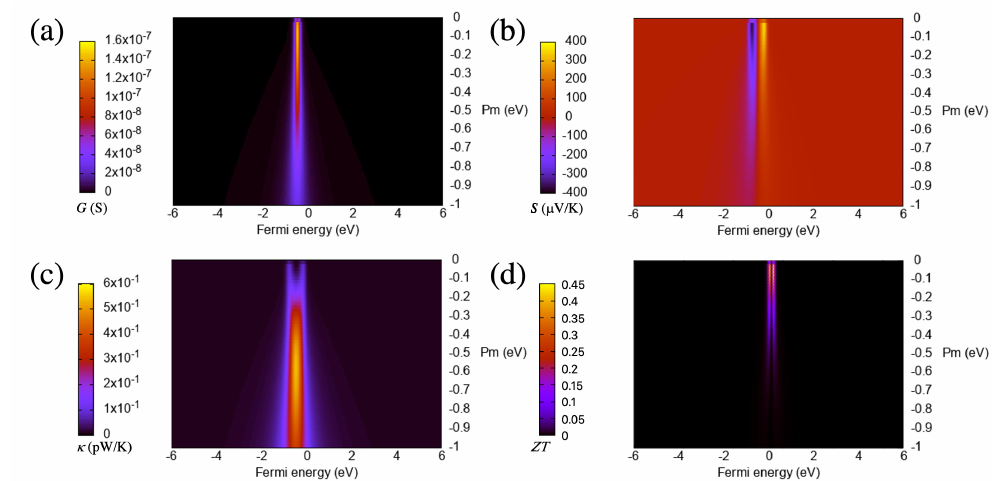
Figure 2. Electrical conductance ( a ), Seebeck coefficient ( b ), electronic thermal conductance ( c ) and figure of merit ( d ) as a function of the Fermi energy and the coupling parameter for the wedge–edge configuration. The temperature is 300 K.